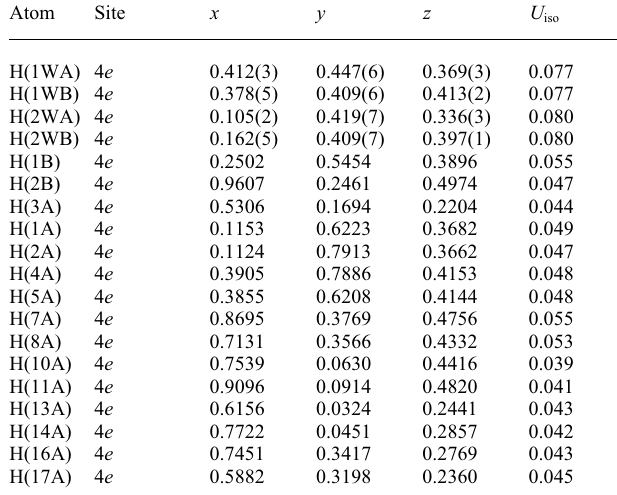
Table 1. Data collection and